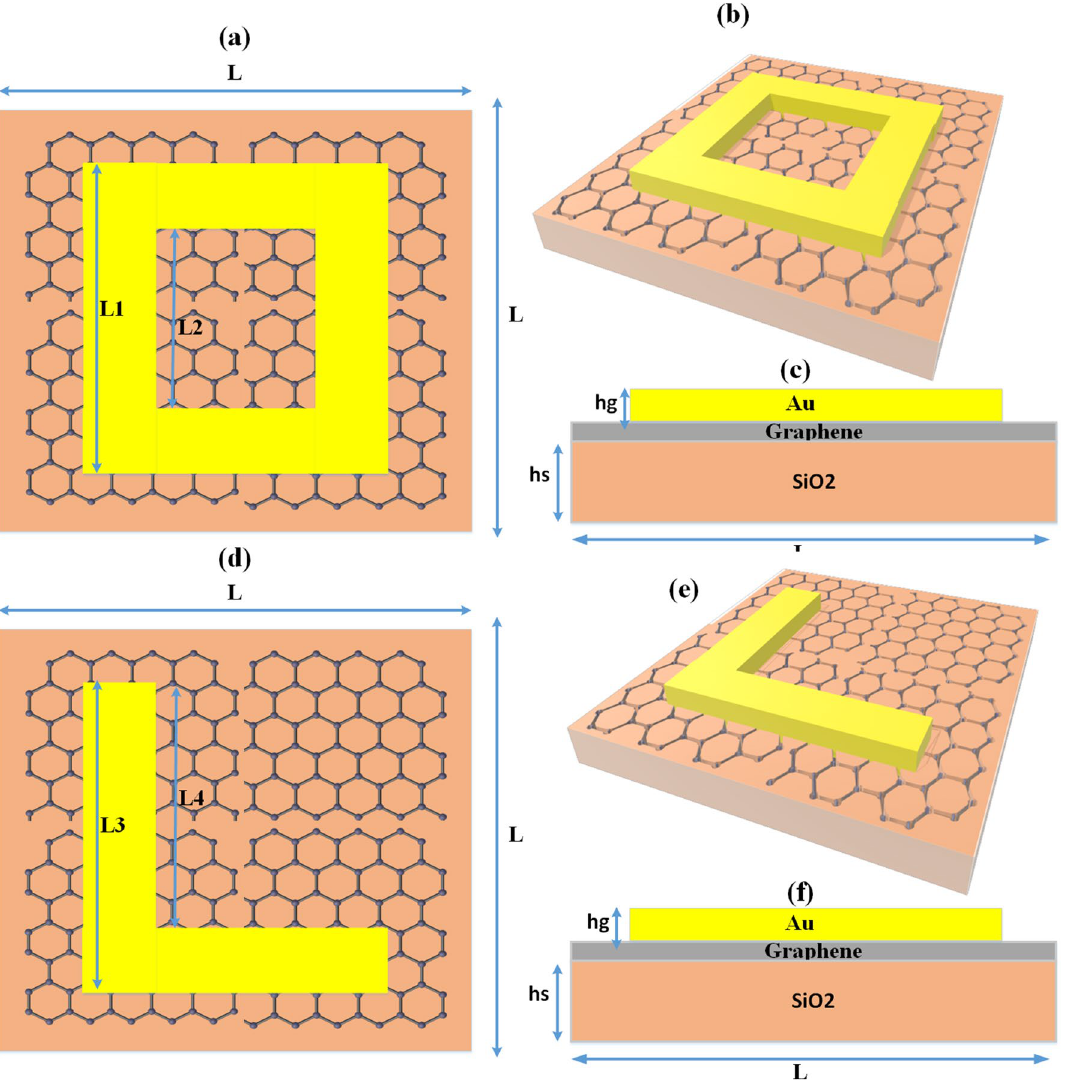
Figure 1. Graphene-based metasurface design ( a ) O-shape metasurface design top view having size L1 = 2.4 µm, L2 = 1 µm ( b ) O-shape metasurface design 3D view ( c ) O-shape metasurface design front view ( d ) O-shape metasurface design top view having size L3 = 2.4 µm, L4 = 2.2 µm ( e ) O-shape metasurface design 3D view ( f ) O-shape metasurface design front view. The overall area of the structure 3 × 3 µm 2 The dimensions are not up to the